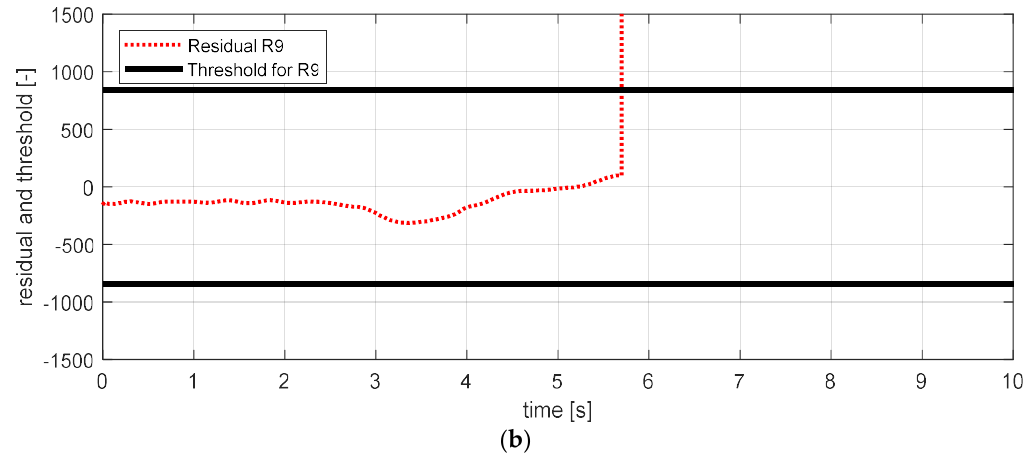
Figure 32. Simulation result for wheel vertical acceleration sensor—fl (fault). ( a ) Residual 7 and threshold; ( b ) residual 9 and threshold.